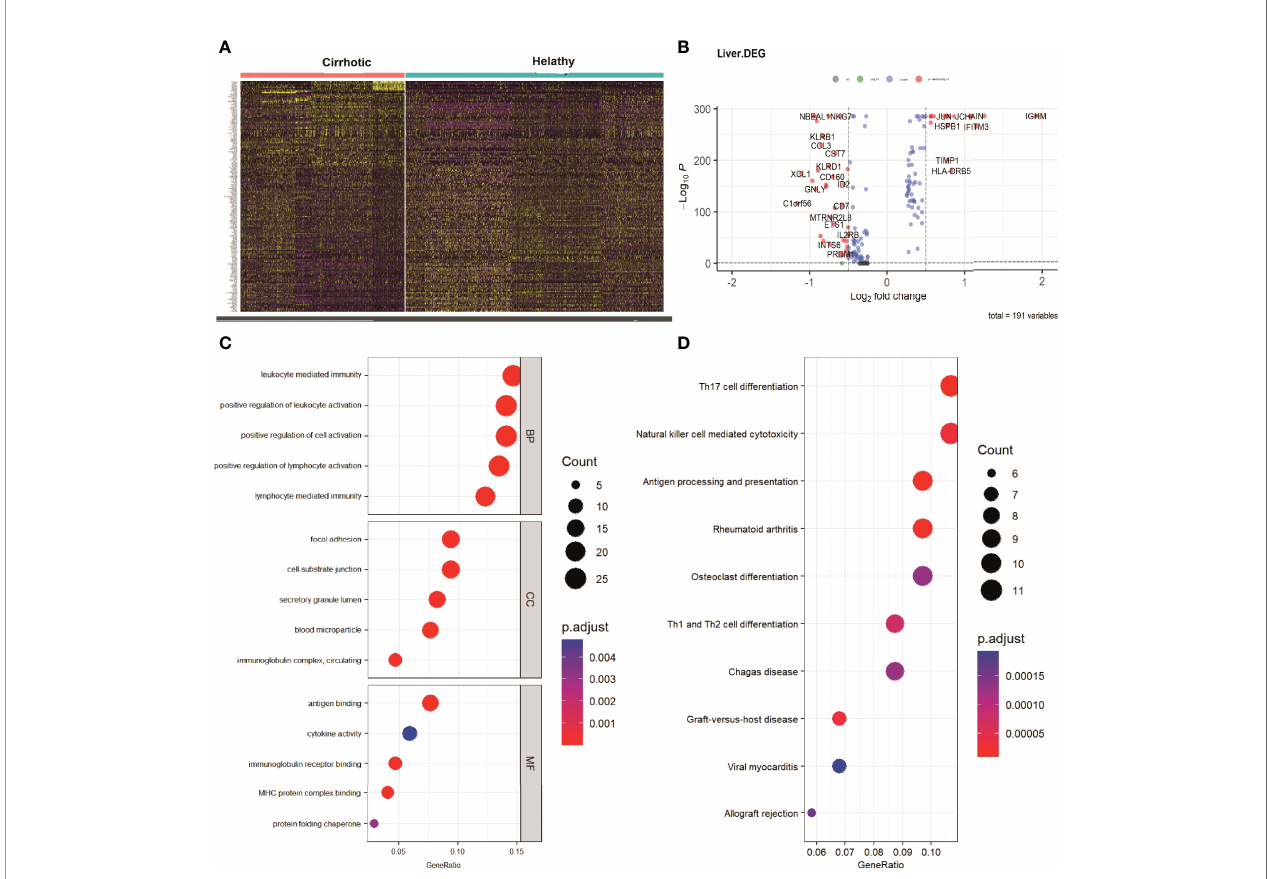
FIGURE 3 | DEGs of cirrhosis from scRNA sequencing data. (A) Heatmap of all the DEGs. (B) Volcano plot (|logFC| > 0.25 and adjusted P value < 0.05).The DEGs are colored red. (C) GO analysis of DEGs. The top 5 biological processes (BP), the top 5 cellular components (CC), and the top 5 molecular functions are shown. (D) The top 10 KEGG pathways of